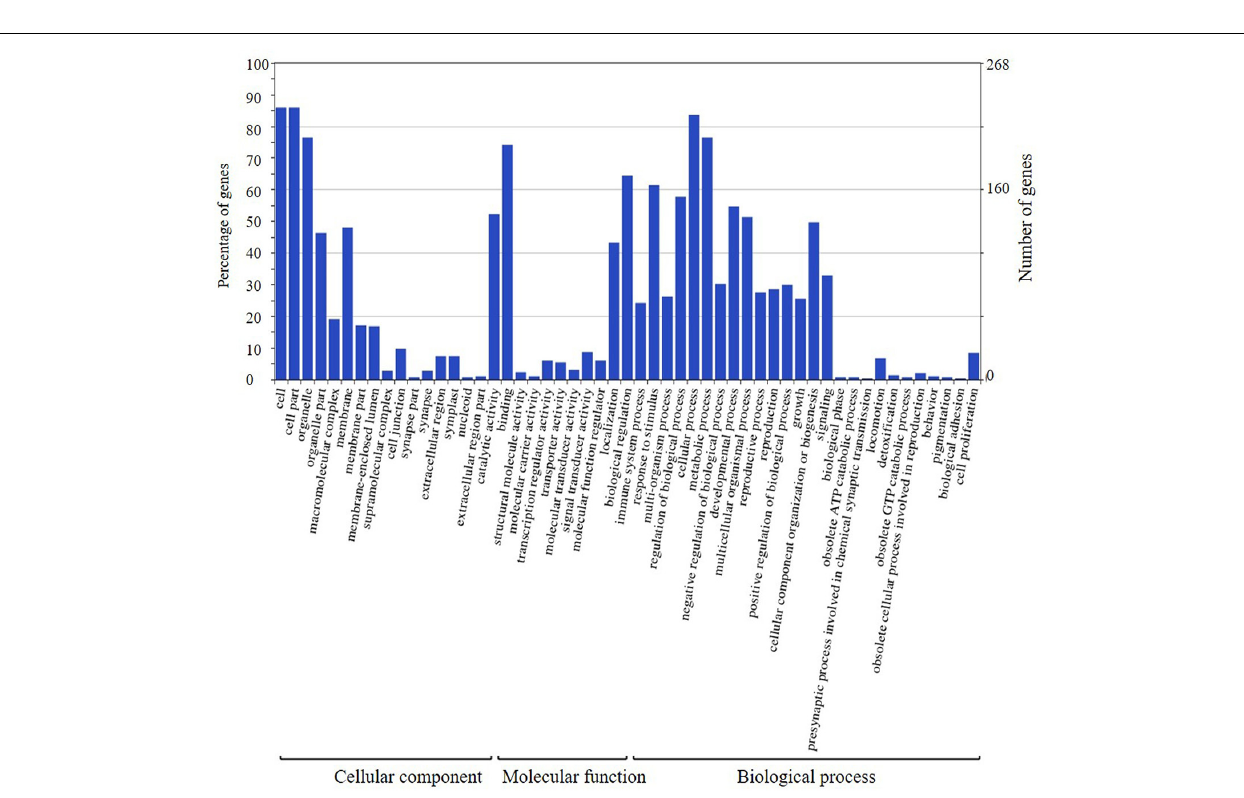
Frontiers in Plant Science |